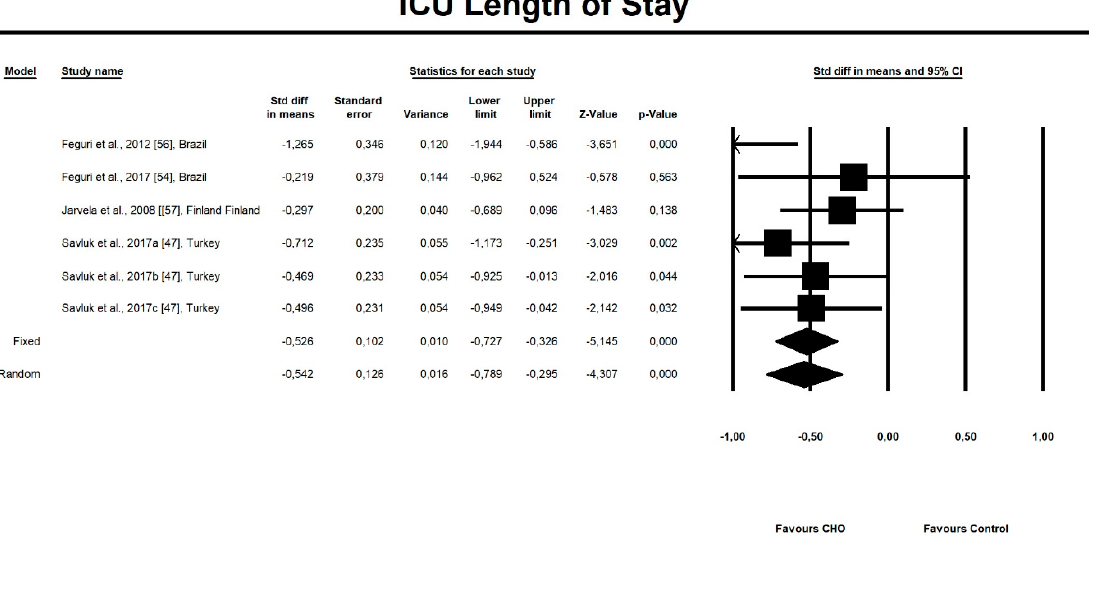
Figure 3. An effect size, difference in means, for aortic clamping (AC) duration (minutes) in patients taking oral carbohydrates (OCH) drinks vs. controls. 95%Cl – 95% confidence interval.